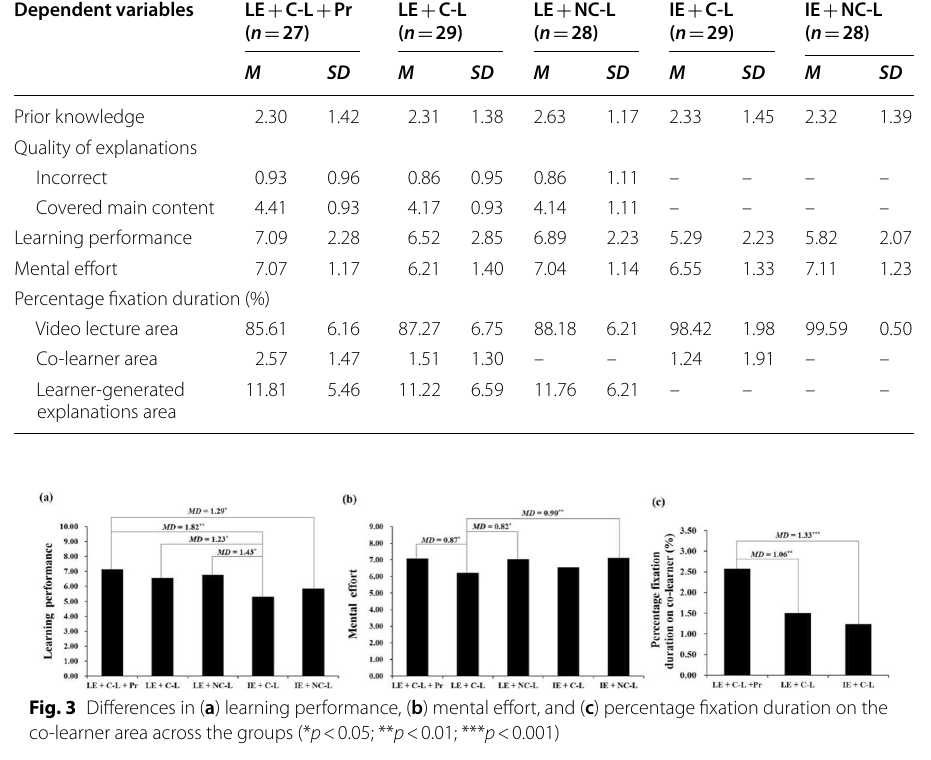
Table 2 Means ( M ) and standard deviations ( SD ) for all dependent variables Dependent variables